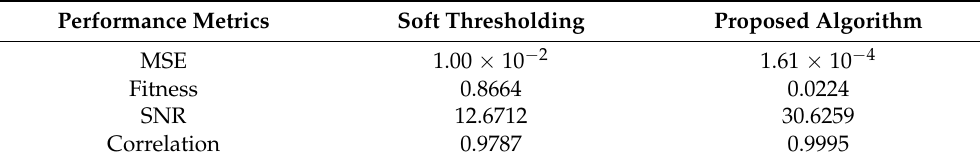
Figure 7. ( a ) The recovered sparse signal from the proposed algorithm; ( b ) The recovered sparse signal from soft thresholding. Table 1. Performance comparison of different sparsity transforms using mean squared error in the transform domain. Temporal FFT performs better in cardiac cine MRI .